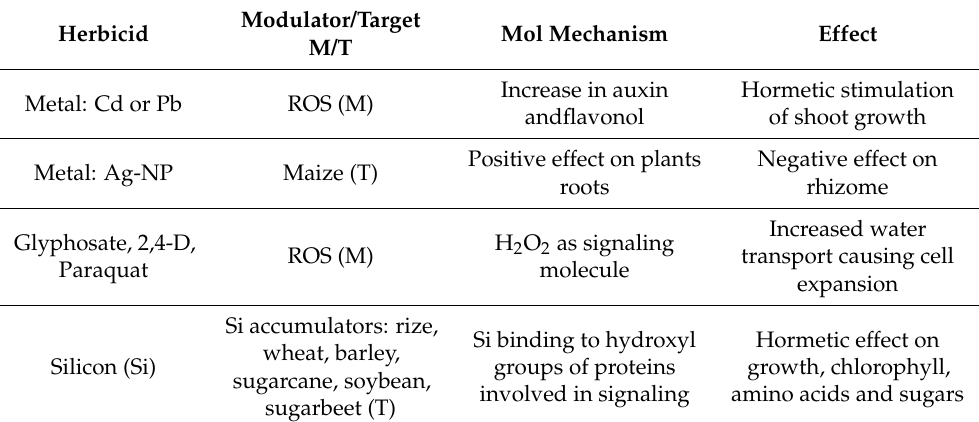
Table 6. Herbicid hermetic effects in